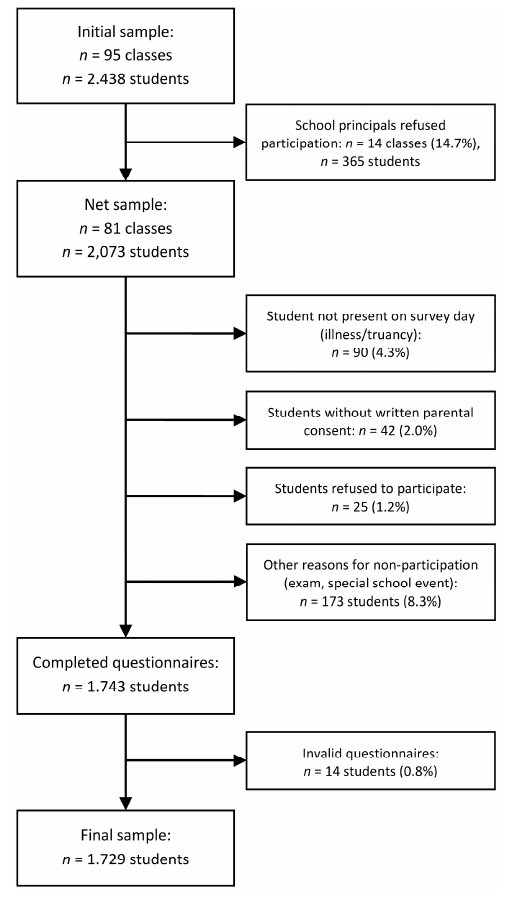
Figure 1. Flowchart of sampling procedure and reasons for non ‐ participation.